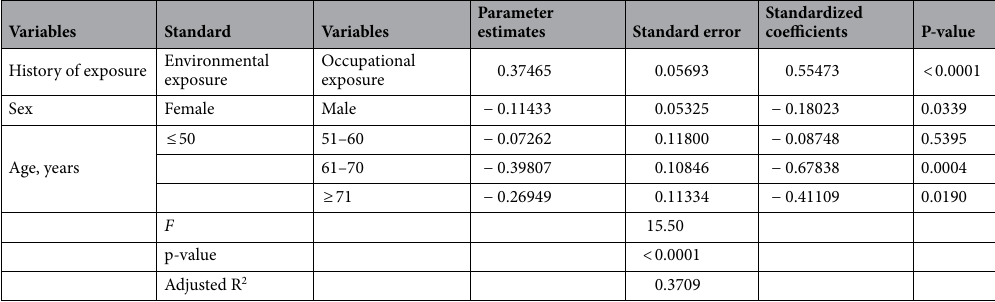
Table 4. Results of multiple regression analysis of affecting factors of asbestos burden.